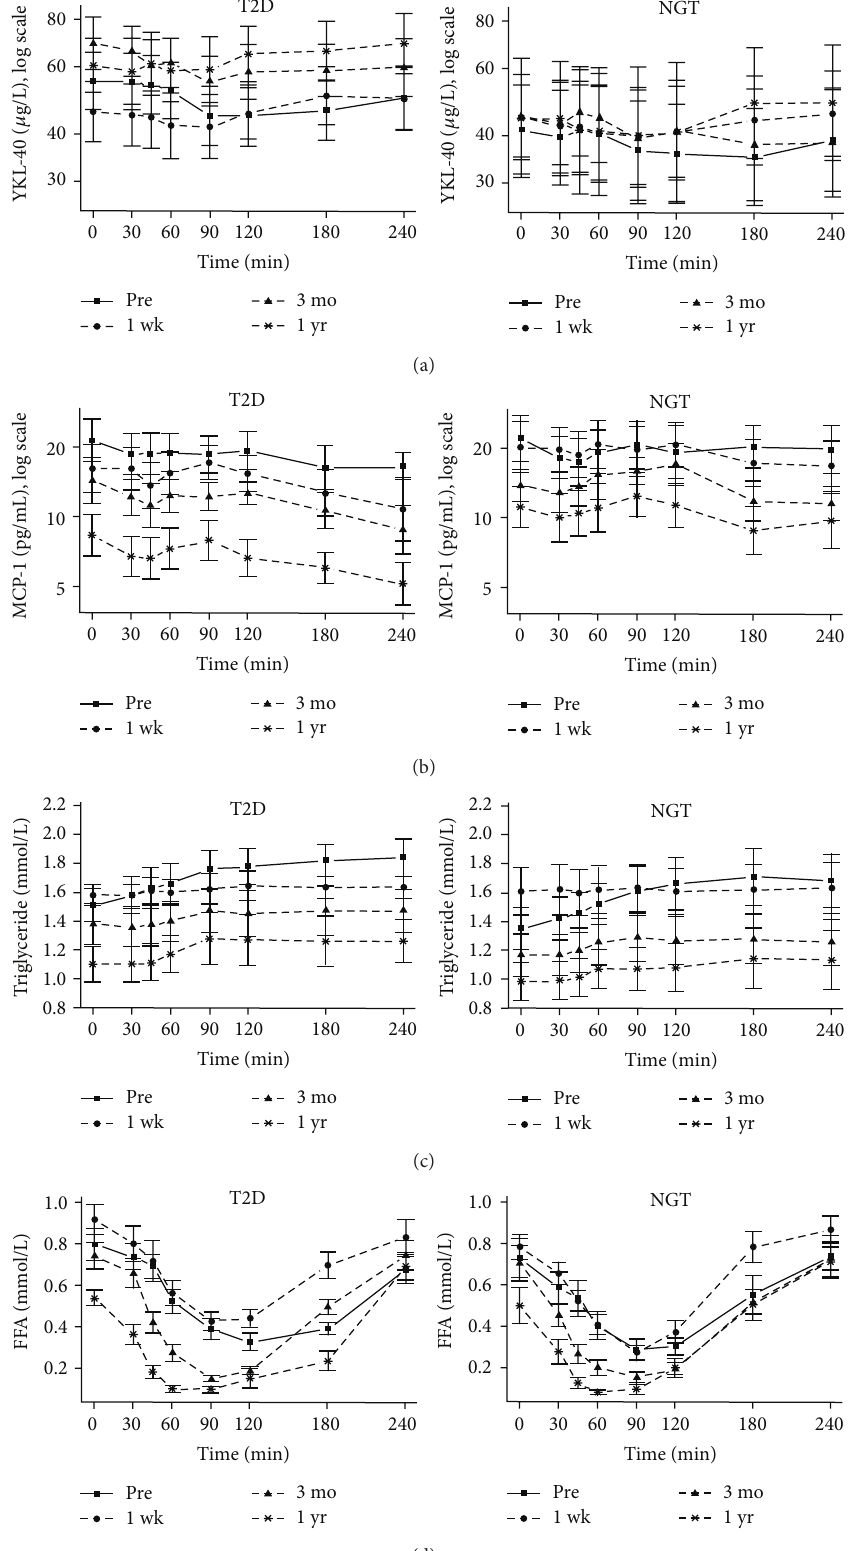
Figure 1: YKL-40 (a), MCP-1 (b), triglyceride (c), and free fatty acids (FFA) (d) in response to a meal in subjects with type 2 diabetes (T2D) and with normal glucose tolerance (NGT) before (pre) and 1wk, 3 mo, and 1yr after Roux-en-Y gastric bypass (RYGB). Data are presented as means ± standard error of mean